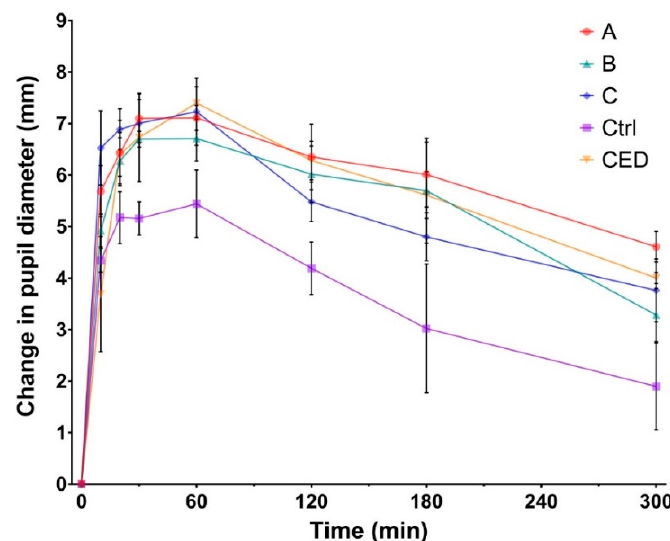
Figure 6. Mydriasis response profiles displayed as change in pupil diameter versus time following the administration of one drop of formulation A, B, and C compared with the administration of one drop of a liquid control solution (Ctrl; tropicamide 0.5% and phenylephrine 5%) and to the administration regimen of commercially available eye drops (CED; four drops of Mydriaticum® TPC 0.5% and four drops of Neosynephrine Faure® PHE 10%).